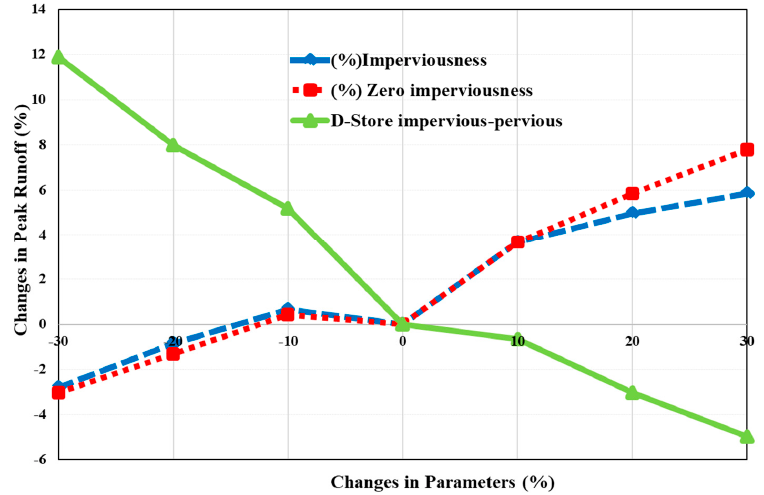
Figure 4. Sensitivity analysis results for SWMM model.